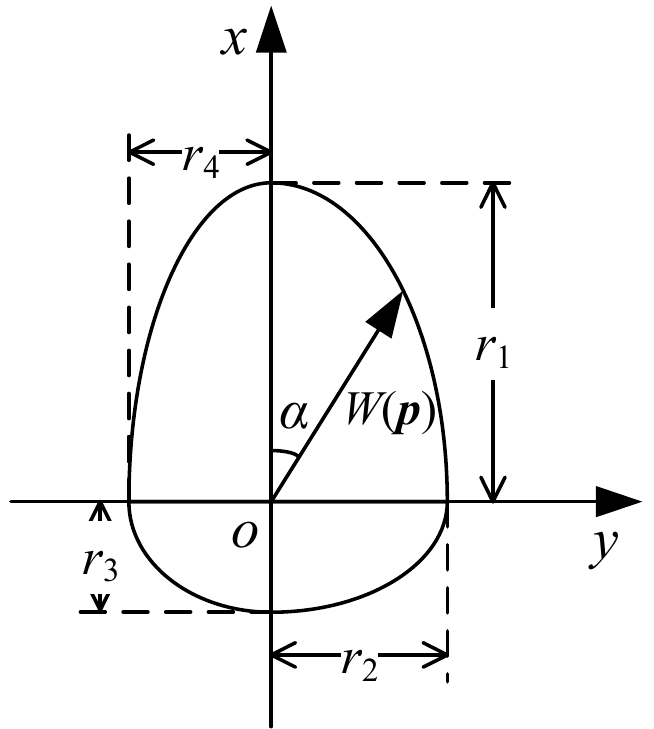
Figure 3. The speed function of the FM method designed for dynamic obstacles.